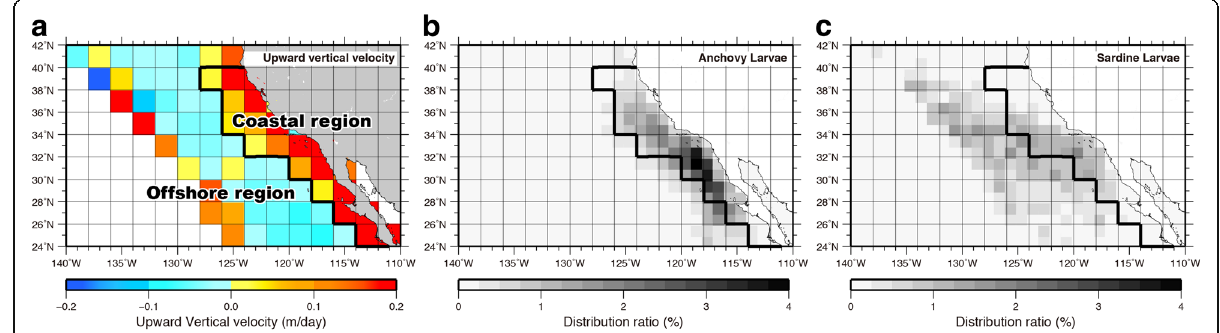
Fig. 8 Simulated horizontal spatial distributions of anchovy and sardine larvae averaged over the historical simulation. a Distribution of the vertical velocity and the boundary between the coastal region and offshore region denoted as black lines. Upward velocity was positive. b Distribution ratio during larval stage for anchovy and c for sardine. Distribution ratio was calculated based on the location of each super-individual and weighted by its